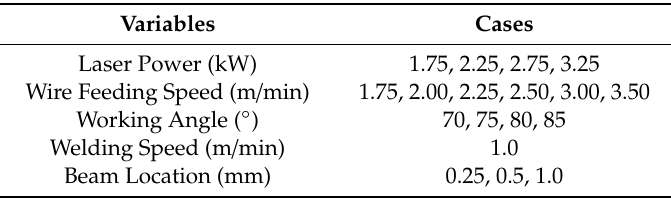
Table 4. Conditions of laser welding for Invar with 3.0 mm thickness.